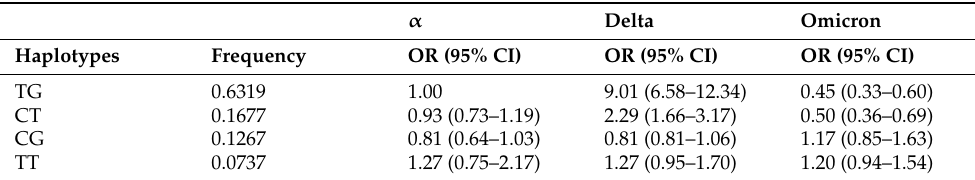
Table 4. SARS-CoV-2 variants and VDR SNPs